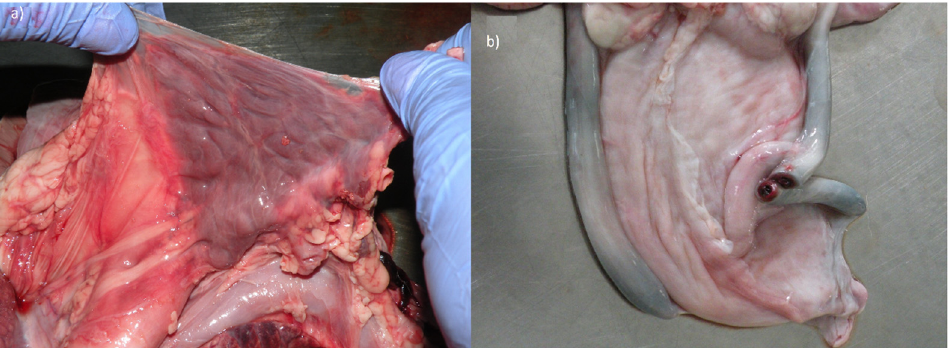
Figure 3. ( a ) The only one part of the thymus in the mediastinum; and ( b ) the unobliterated paired umbilical artery at the urinary bladder. On the right, its cross ‐ sectional